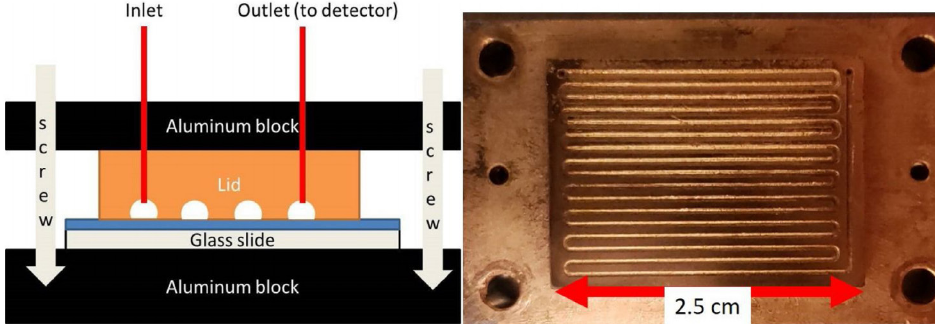
Figure 2: Schematic diagram of MEMs column prepared by an epoxy resin